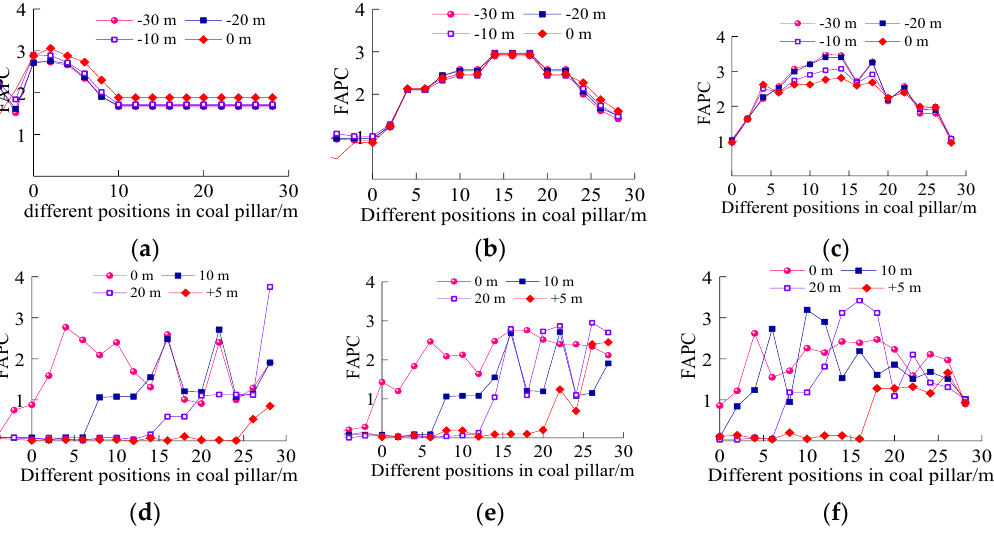
Figure 21. Distribution characteristic curves of the different layers RSCC of working face passing the coal pillar: ( a ) 6 m layer RSCC before the pillar, ( b ) 14 m layer RSCC before the pillar, ( c ) 24 m layer RSCC before the pillar, ( d ) 6 m layer RSCC enter the pillar, ( e ) 14 m layer RSCC enter the pillar, and ( f ) 24 m layer RSCC enter the pillar. (Note: “ − ” represents before the coal pillar, “+” represents after the coal